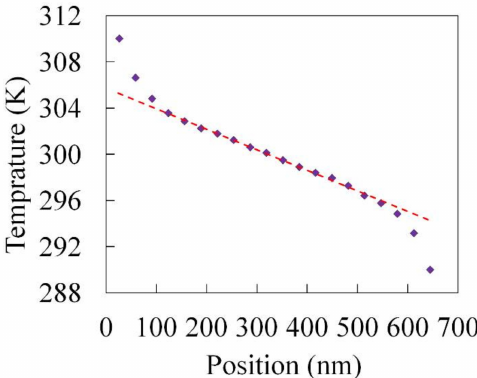
Figure 5. The temperature gradient along the longitudinal direction including the average temperature of all twenty layers for a single-layer sheet with length of 33 nm at 300 Kelvin. To calculate a linear relation of dT / dx , the temperature gradient without the average temperature of the first and last three layers was considered and dT / dx was determined according to the slope of the dotted red line.